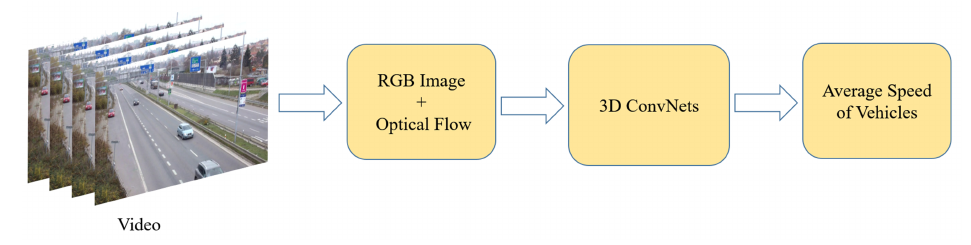
Figure 1. Flow Chart of Our